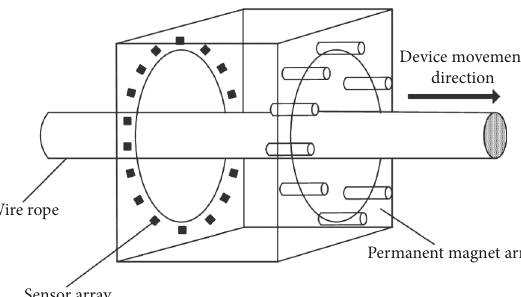
Figure 1: Schematic diagram of the MFL data acquisition device under unsaturated magnetic